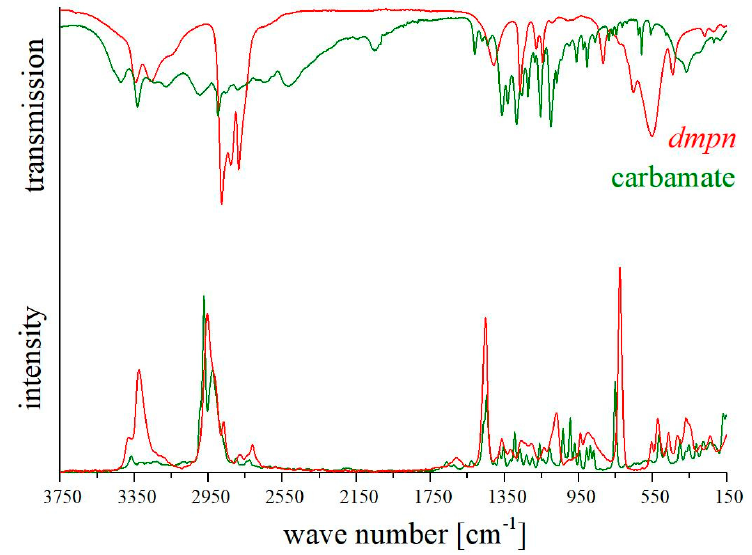
Figure 3. Raman and IR spectra of 2,2-dimethyl-1,3-diaminopropane (red) and (3-ammonio-2,